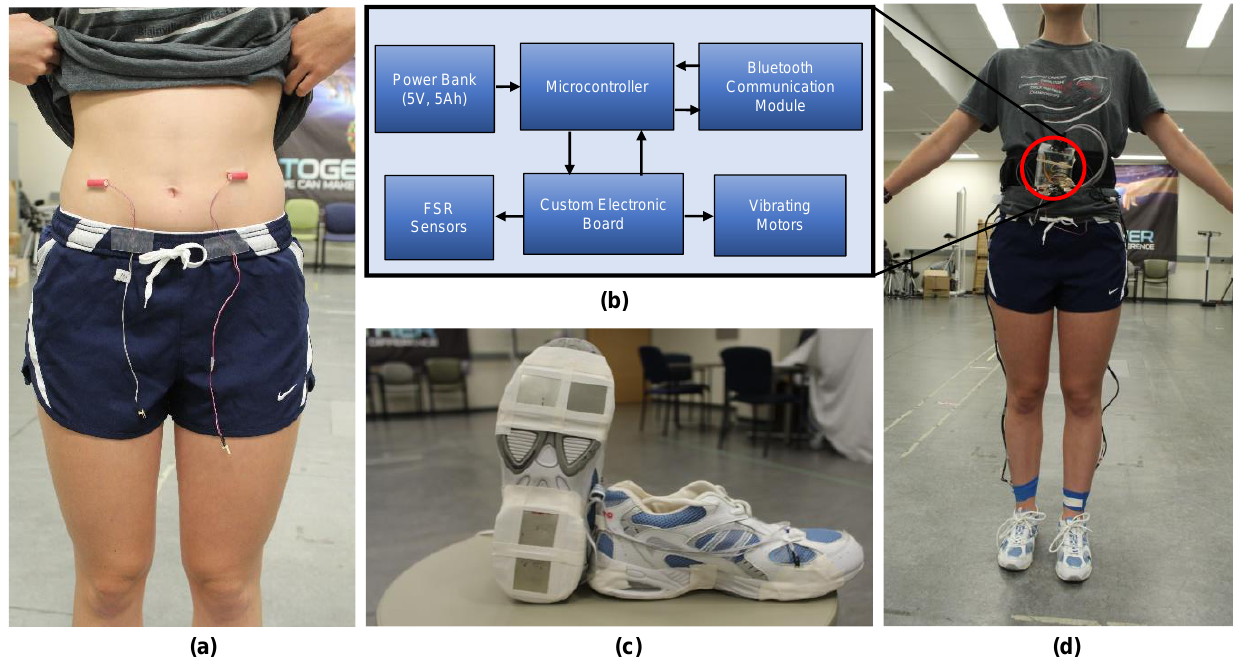
Figure 1: Main components of the wearable BFB prototype (vibrating motors, microcontroller, Bluetooth, power supply, and FSRs sensors). (a) Vibrating Unit (motors) located at the lower abdomen at the prolongation axis of the rectus femoris muscle. (b) Microcontroller-based Control Unit, including the custom electronic board, the communication (Bluetooth) module, and the power supply. (c) Sensors/Transducer Unit comprises four FSRs sensors located at the heel (x2) and toe (x2) of each shoe sole. (d) Set-up of the BFB system on a